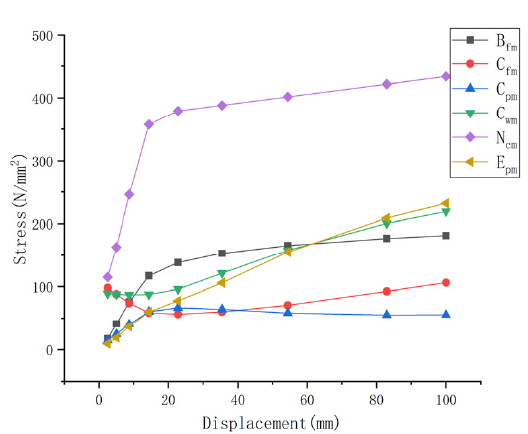
Figure 7. Model stress history.